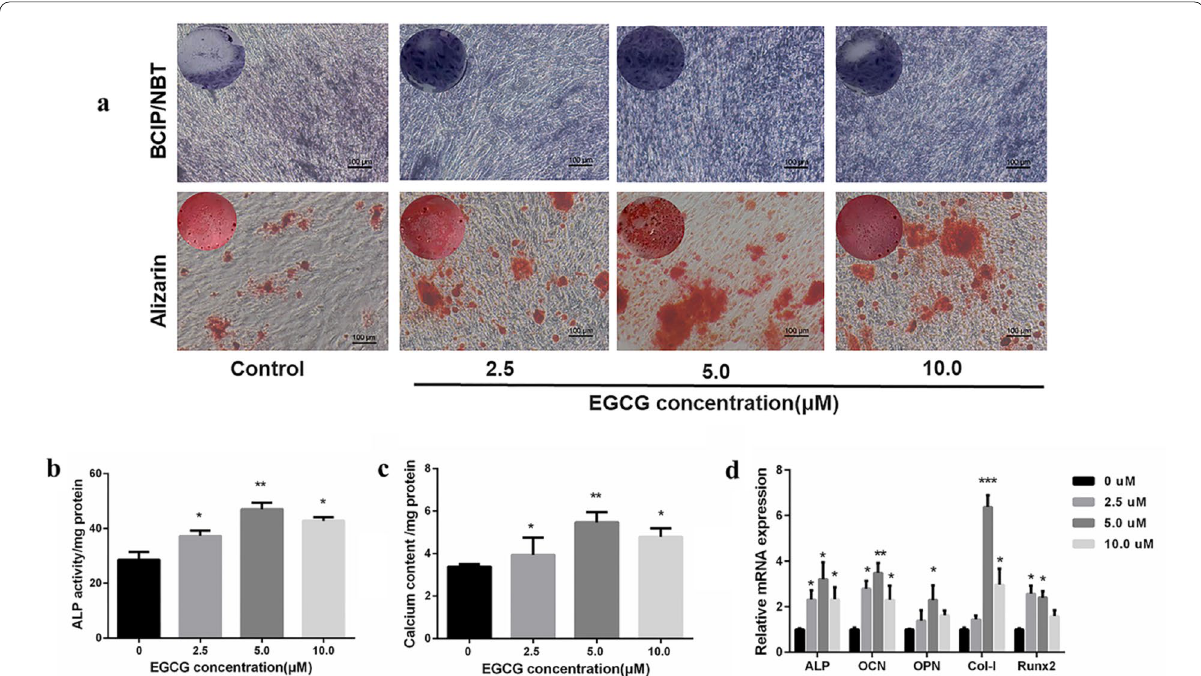
Fig. 2 a The HUMSCs were cultured for 7 days for ALP staining, and the HUMSCs were cultured for 14 days for Alizarin red staining (scale bar: 100 μM). b Quantitative analysis of ALP activity in the HUMSCs cultured for 7 days. c Calcium contents in the HUMSCs cultured for 14 days. d The quantitative evaluation of osteogenic‑related genes in the